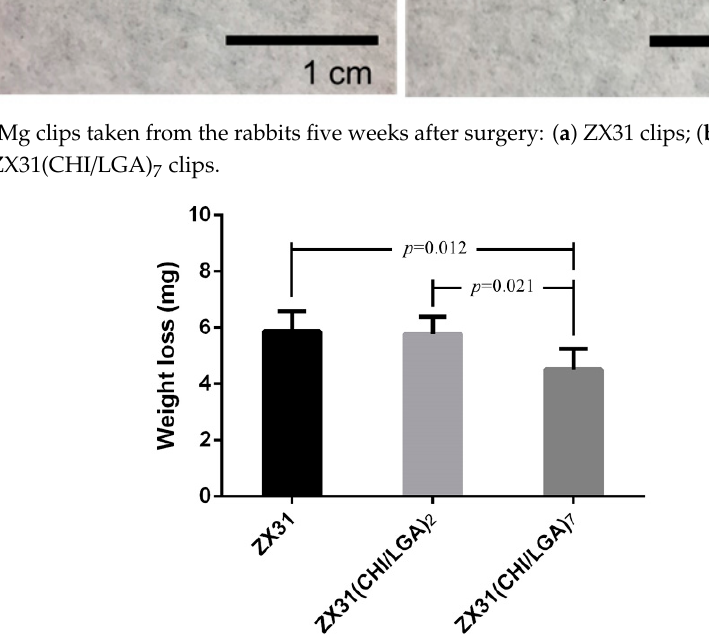
Figure 10. Weight loss of the Mg clips from each group five weeks after surgery ( p values obtained via Scheffe’s method).